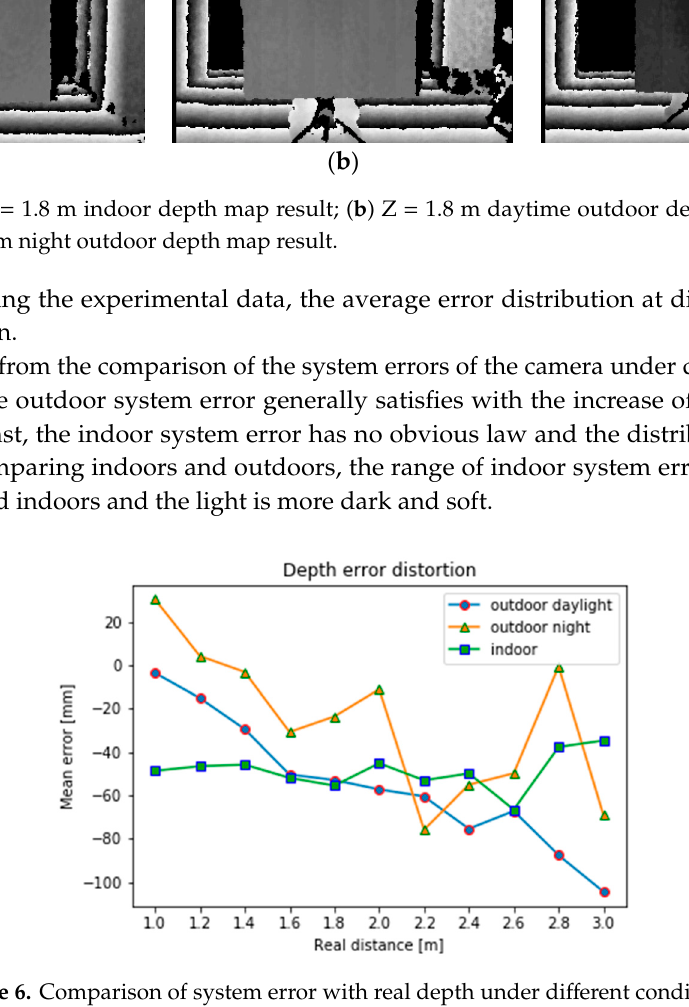
Figure 4. Test equipment.